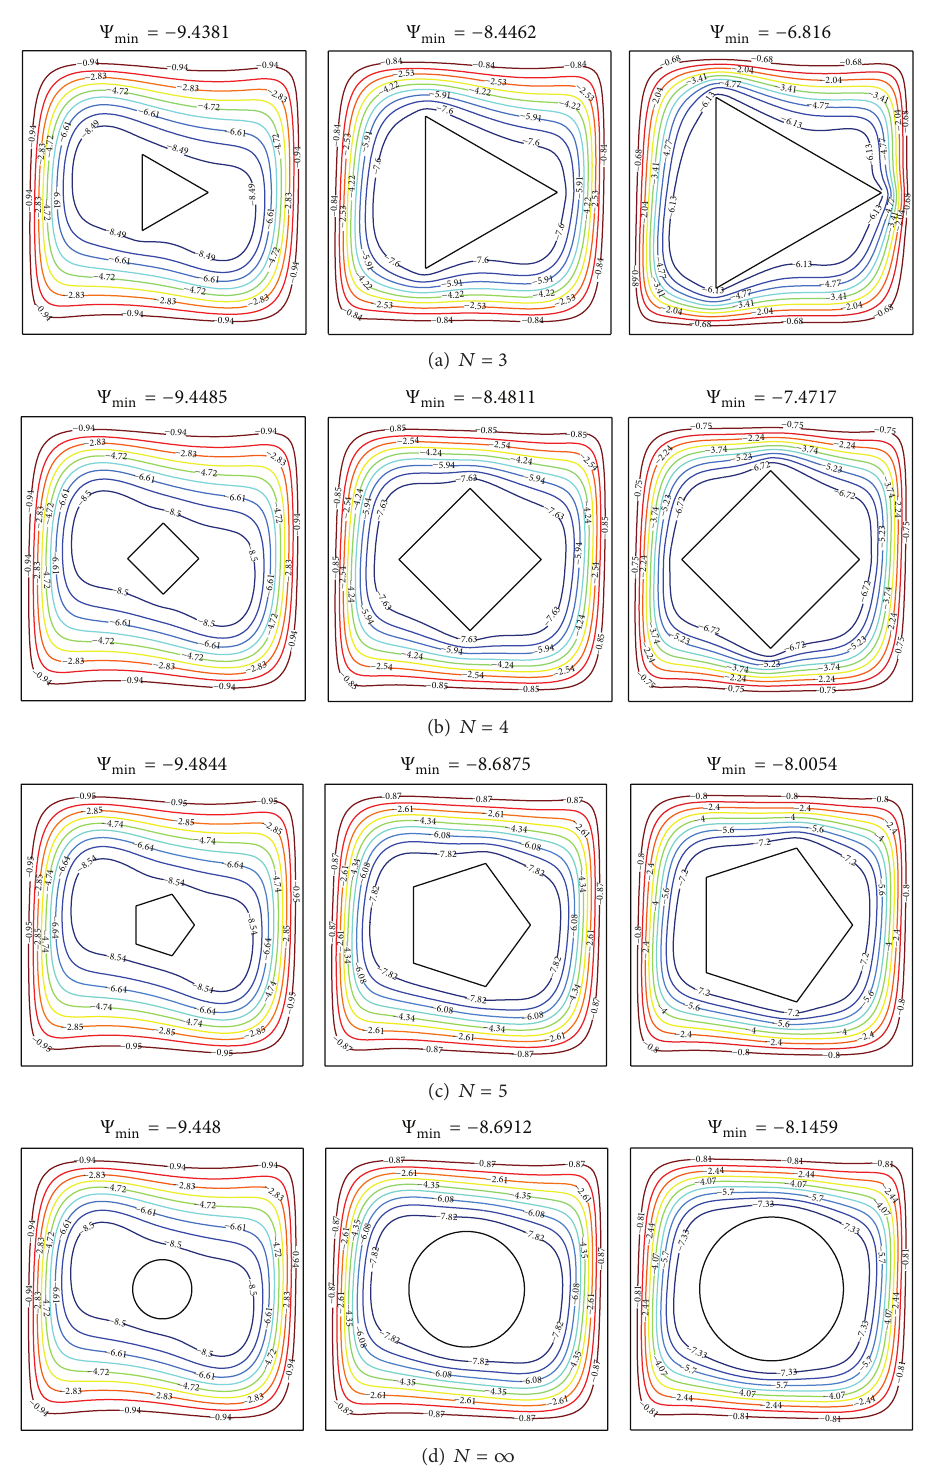
Figure 3: Streamlines for different polygon size 𝐴 and number of polygon sides 𝑁 at 𝐾 𝑟 = 1.0 , 𝑋 0 = 0.5 , and Ra = 10 5